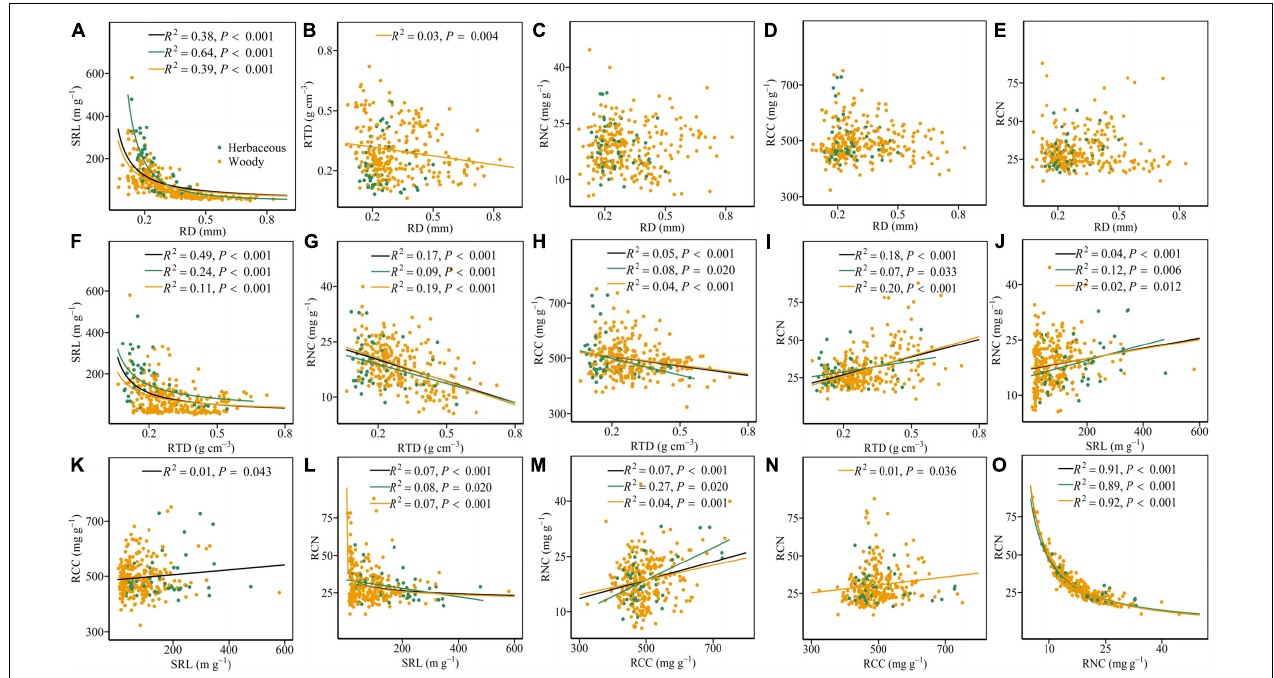
FIGURE 1 | Pairwise relationships of the six root traits for all species (black) and within herbaceous (green) and woody species (yellow) (A–O) . The R 2 (coefficient of determination) and P -values are obtained from the linear and non-linear regression analyses. RD, root diameter; SRL, specific root length; RTD, root tissue density; RNC, root N content; RCC, root C content; RCN, root C:N ratio.